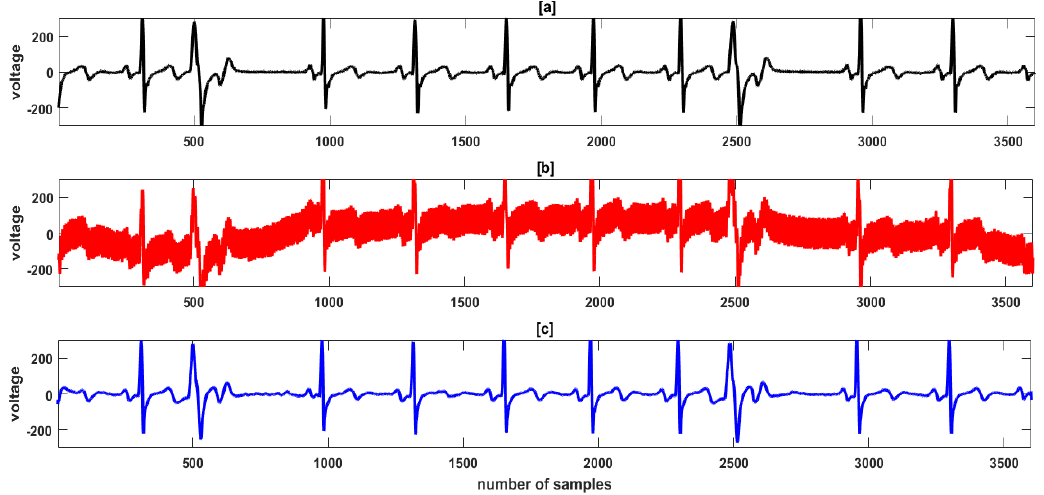
Figure 8. ( a ) Original clean input ECG record no. 119 ( b ) Noisy signal with 50 Hz PLI noise and baseline wander at SNR 0 dB ( c ) Denoised output signal using IF-LWT method.